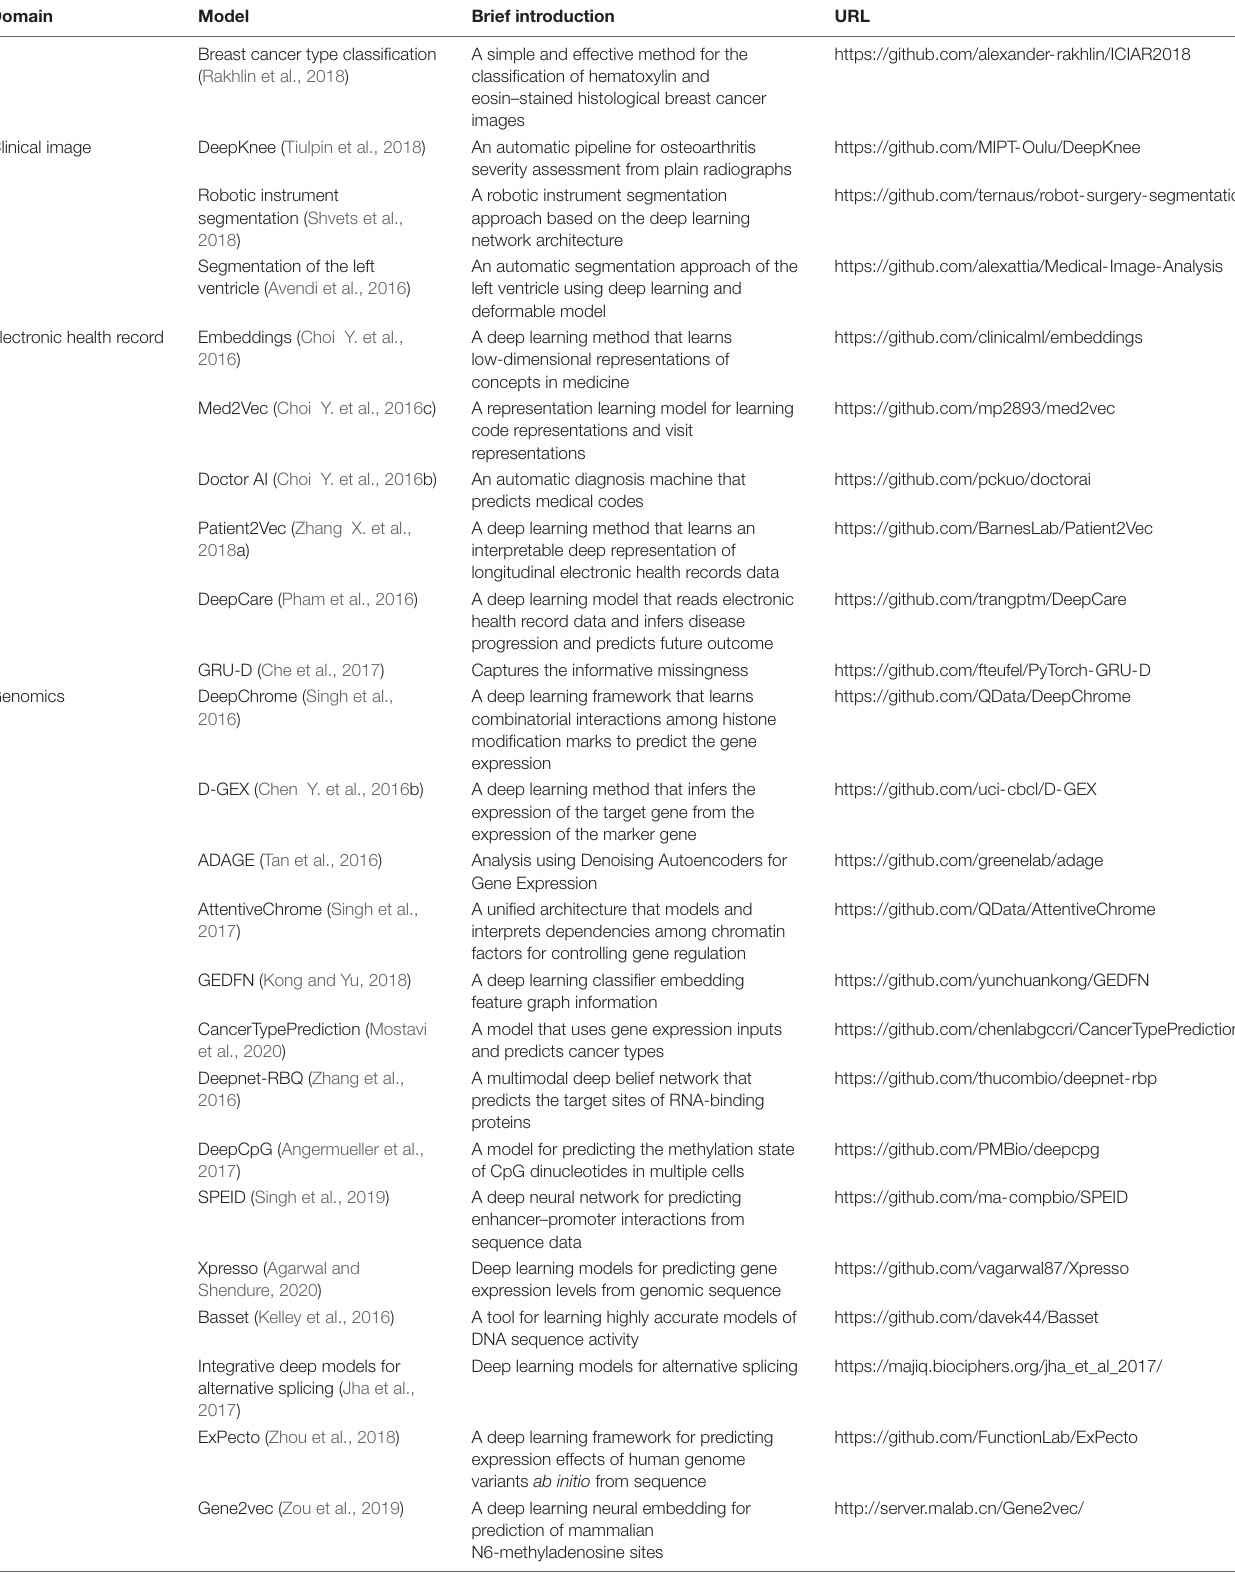
TABLE 3 | Some deep learning models used in computational medicine.